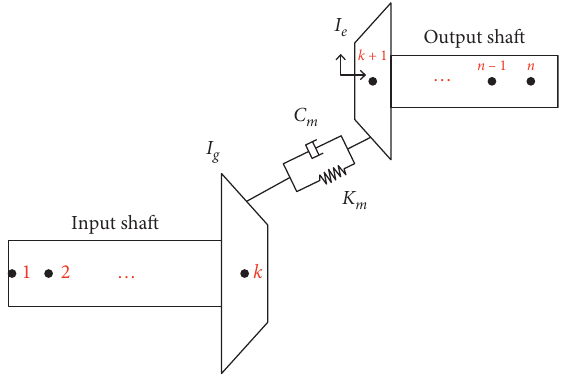
Figure 1: Dynamic model of the spiral bevel geared transmission